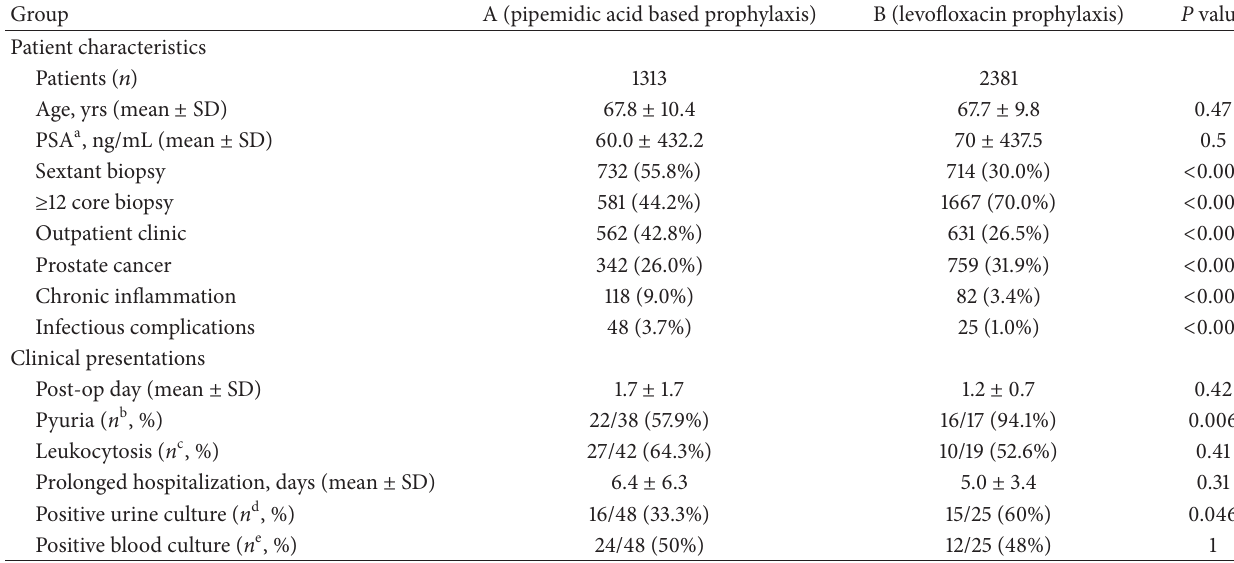
Table 1: Patient characteristics and clinical presentation of infectious complications.